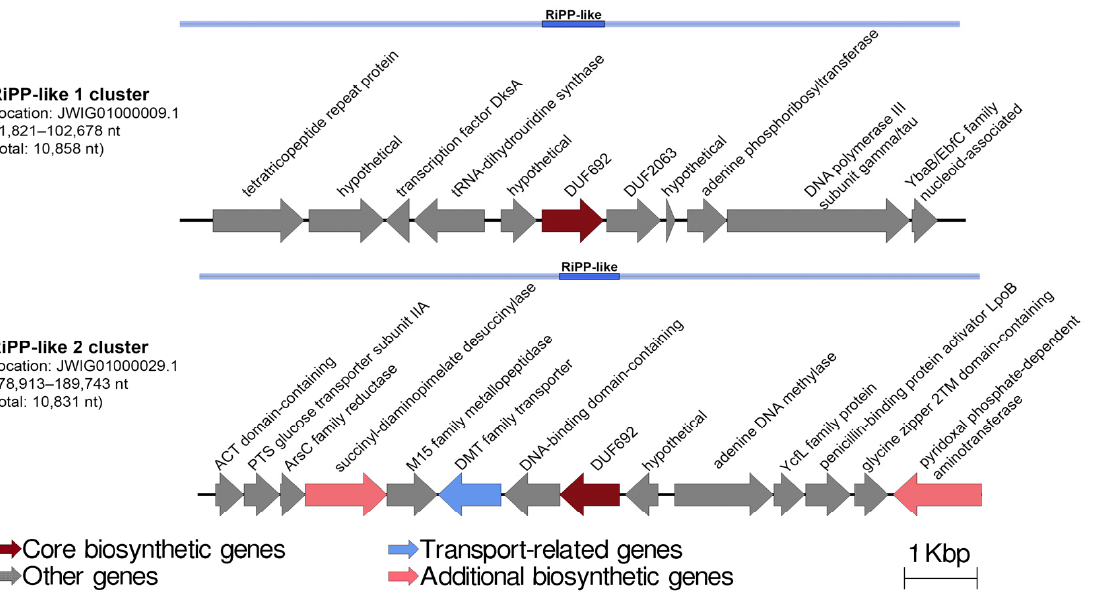
P. translucida KMM 520 T , P. agarivorans DSM 14585 T , and “ P. telluritireducens ” DSM